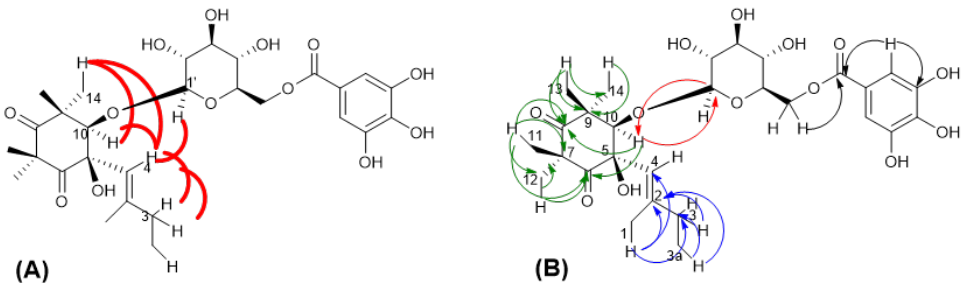
Figure 5. Selected NOESY correlation ( A ) and H–C long-range correlations ( B ) of compound 1 evidenced in and